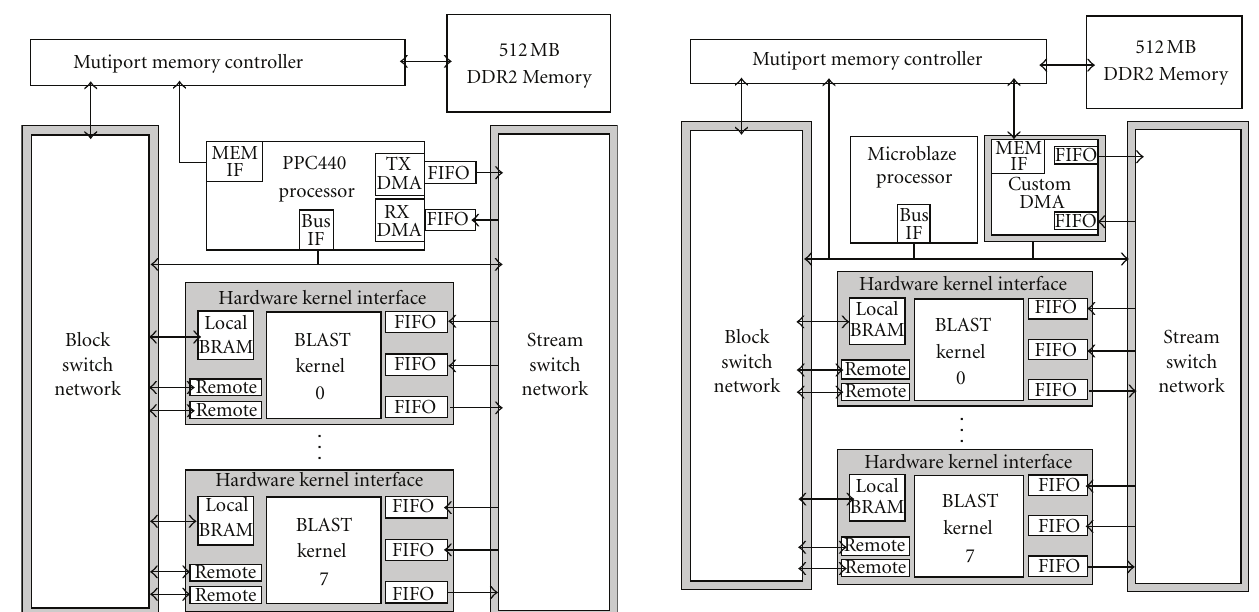
Figure 8: MicroBlaze BLAST system.